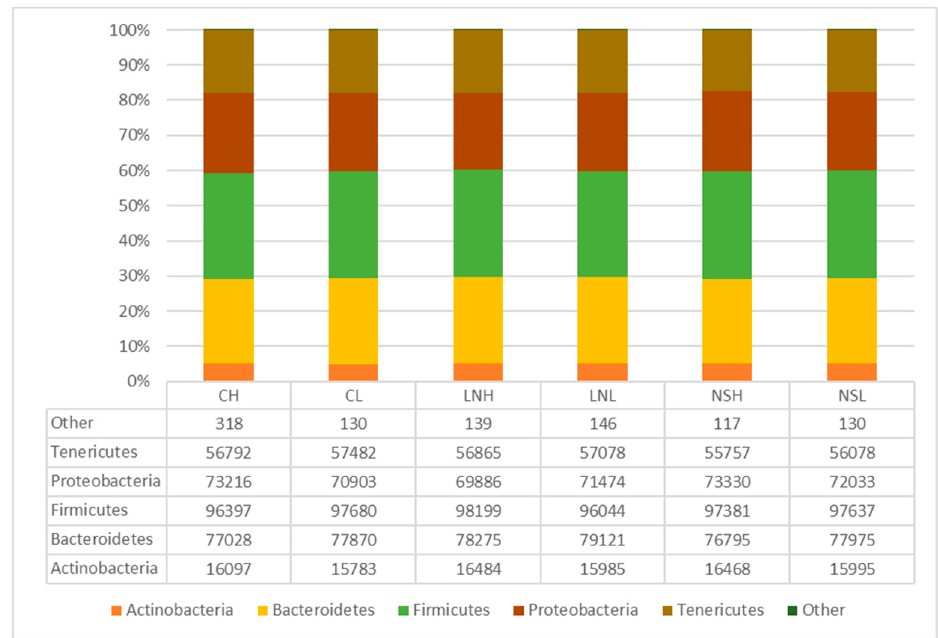
Figure 2. Relative abundance of bacterial phyla found in the sequences obtained from 16S rRNA gene-targeted Illumina sequencing. Population codes follow Table 1. The category “Other” (<1%) includes Acidobacteria, Armatimonadetes, Chloroflexi, Fusobacteria, Gemmatimonadetes, Lentisphaerae, Saccharibacteria, and Verrucomicrobia.